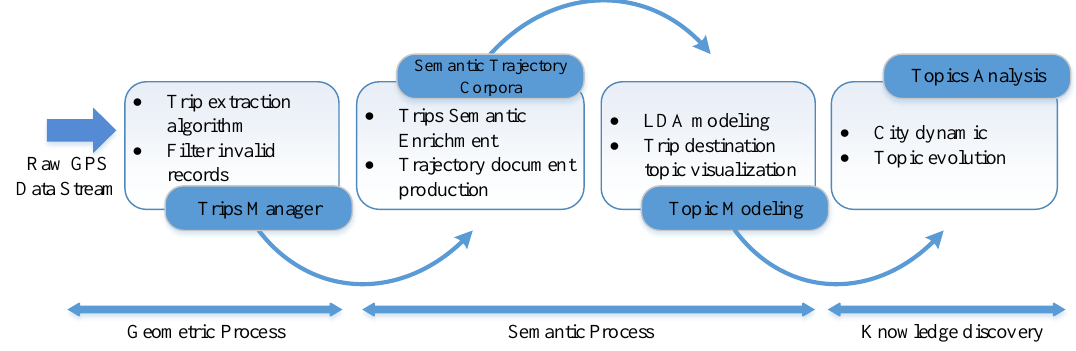
Figure 6. The process of the sematic analysis framework for trip destination.